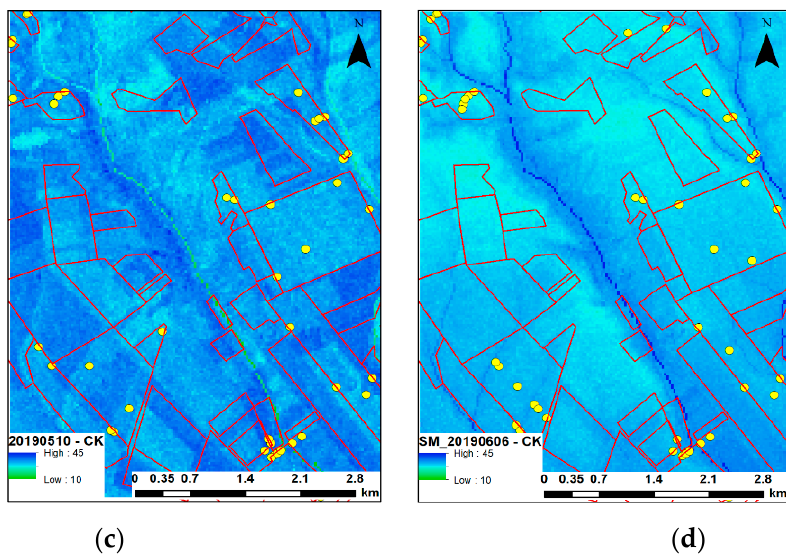
Figure 12. Wheat land use: Ordinary cokriging soil moisture—January, February, May, and June 2019, respectively.